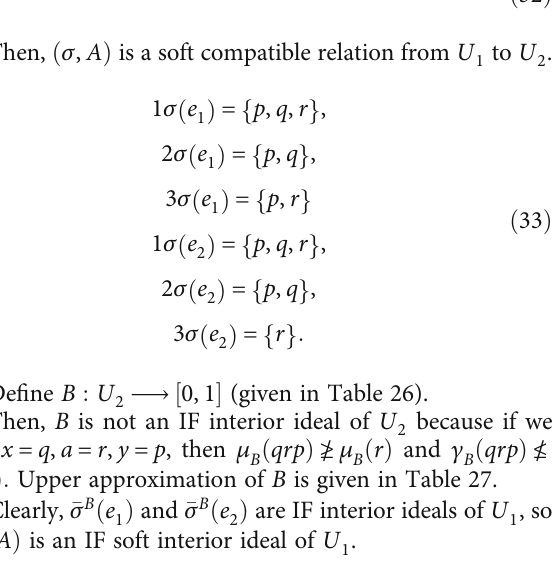
Table 25: Multiplication table for U